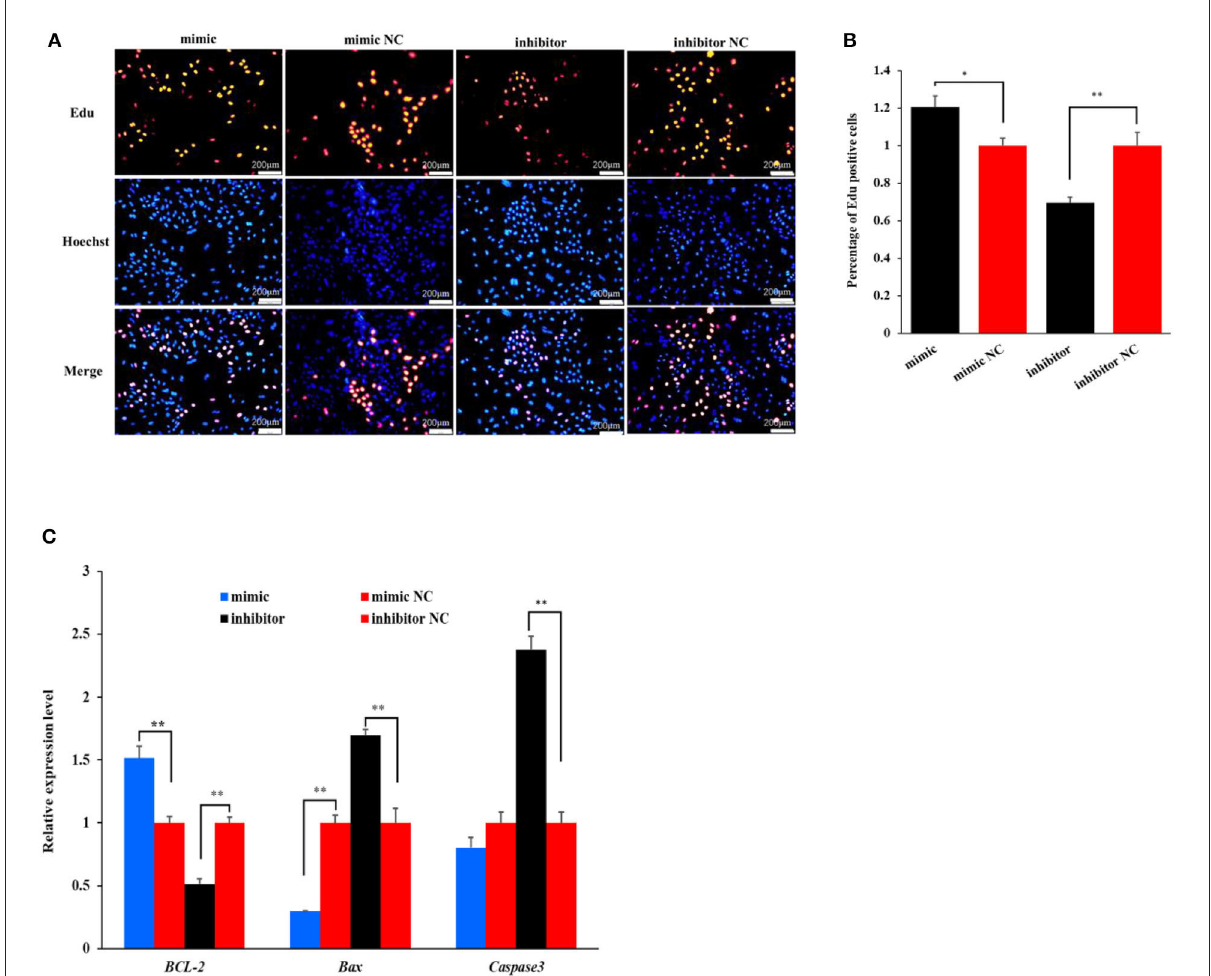
FIGURE2 The effect of miR-199a-3p on the proliferation of ovine mammary epithelial cells (OMECs) when miR-199a-3p mimic and miR-199a-3p inhibitor were transfected into OMECs. (A) The proliferation of OMECs detected using an Edu assay. (B) The percentage of Edu-labeled positive OMECs counted by the ImageJ software. (C) The expression levels of BCL-2 , Bax, and Caspase 3 . ** P < 0.01 and * P <